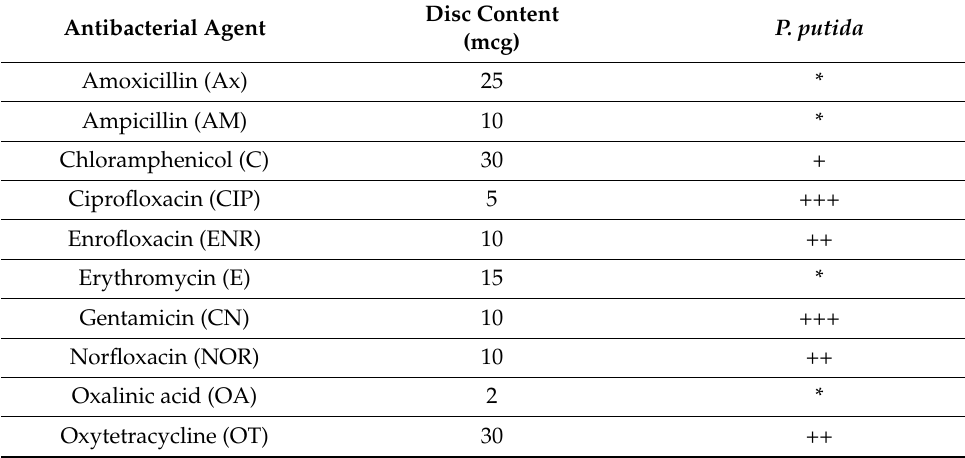
Table 3. Results of antibiotic sensitivity